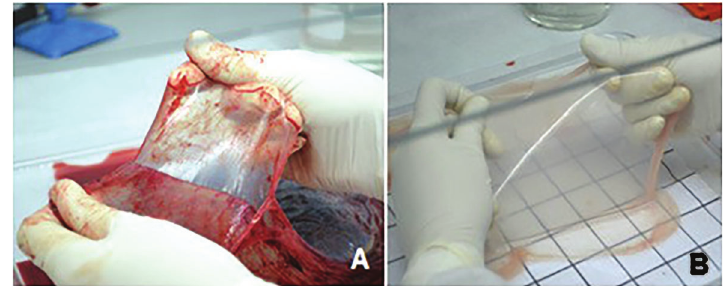
Figure 2. Processing of the amniotic membrane (AM). A , Manual separation of AM from chorion; B , AM after